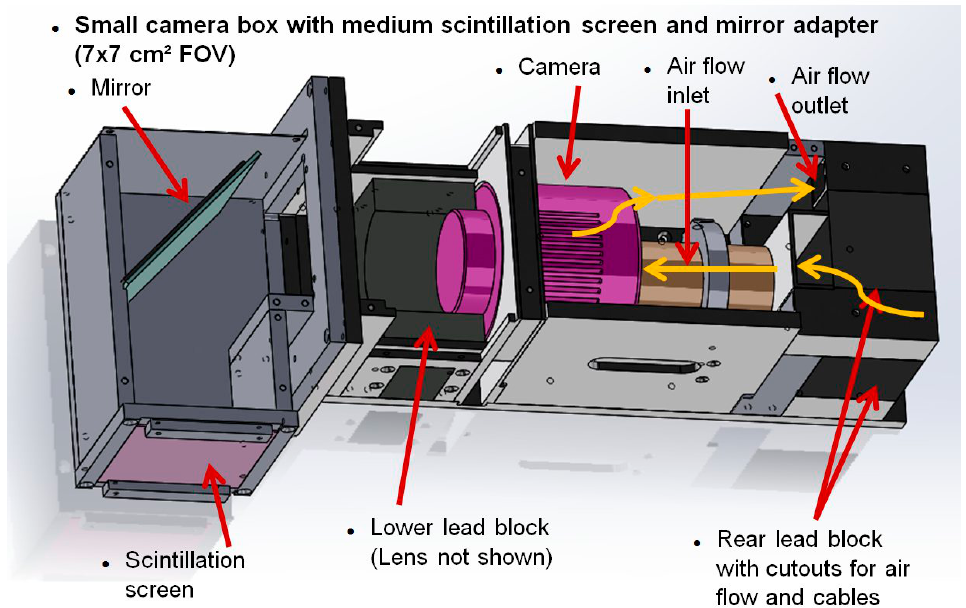
Figure 3. Design of the small camera box. A lead brick surrounds the lens to cut direct sight to the scintillation screen. The mirror box is exchangeable for different sizes.